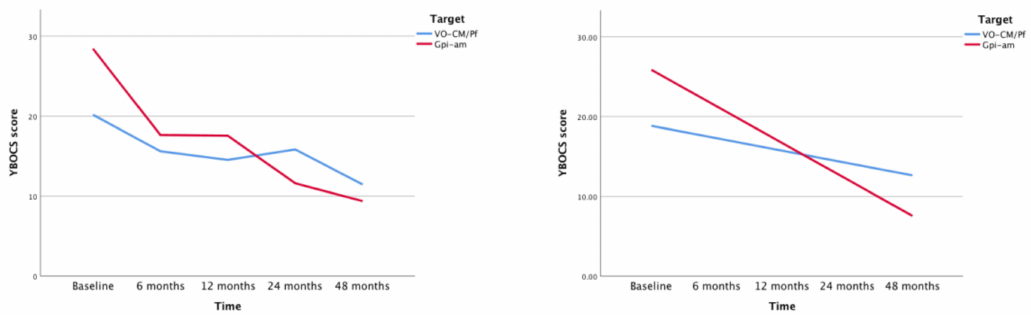
Figure 3. Changes in YGTSS during time. The graph on the left shows di ff erence between slopes of antero-medial Globus Pallidus internus (am-GPi) (red) and Voi-Cm / Pf (blue). The graph on the right represents its linear regression using mixed models.